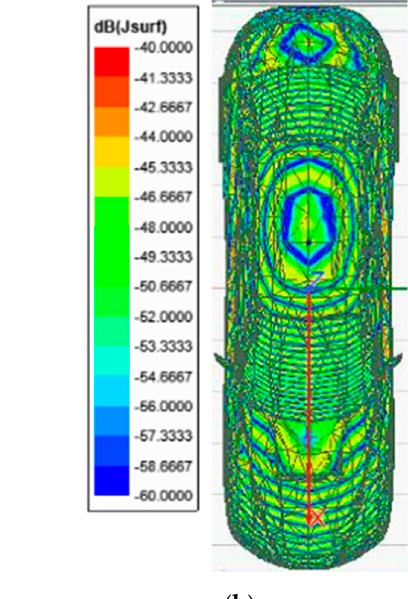
Figure 2. Surface current distribution imaging generated by Ansys HFSS software for a 10 cm long vehicle without antenna (OFF state), illuminated at 300 GHz: ( a ) 3D view of the surface current distribution across the vehicle; ( b ) top view of the surface current distribution.